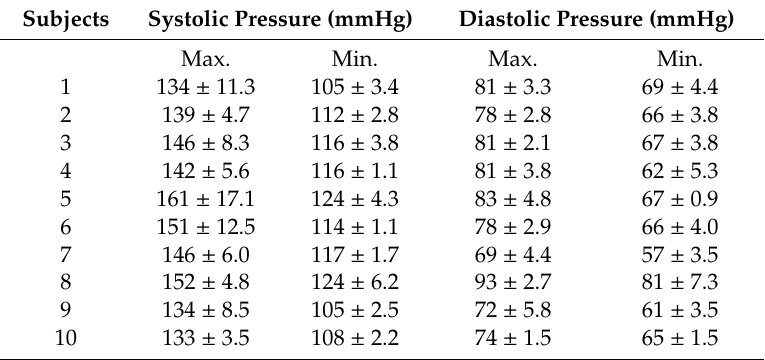
Table 3. The statistics (mean ± SD) of the maximum and minimum blood pressures of subjects in the five exercises. Subjects Systolic Pressure (mmHg) Diastolic Pressure (mmHg)